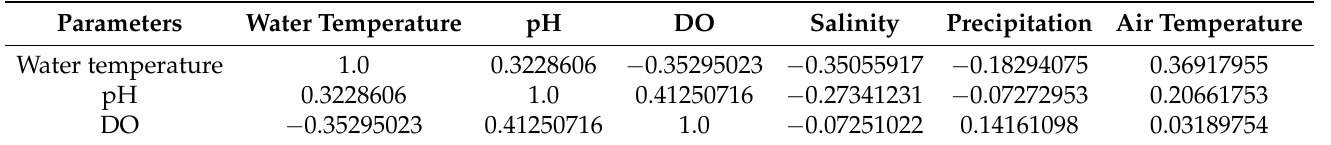
Table 2. Result of correlation